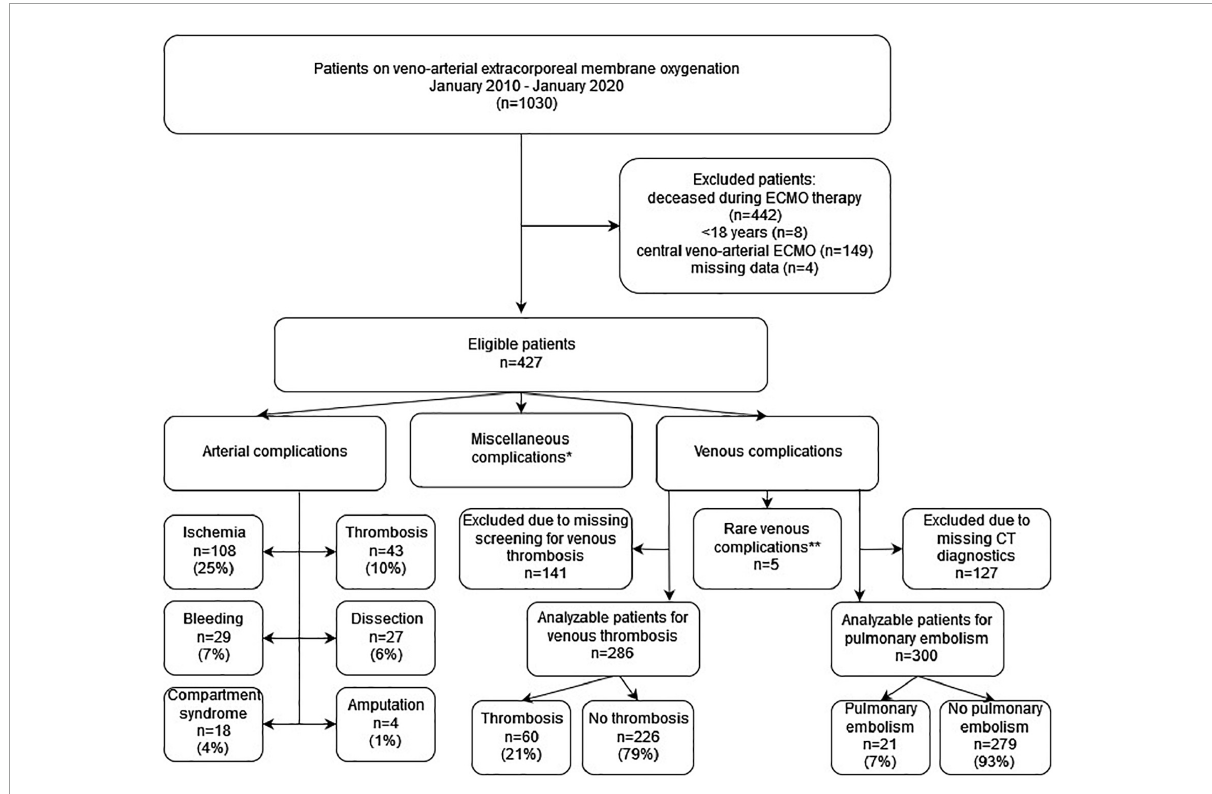
FIGURE1 Flowchart of the observational study evaluating arterial and venous complications in survivors of venoarterial extracorporeal membrane oxygenation of the extracorporeal life support registry at Regensburg; ECMO, extracorporeal membrane oxygenation; CT, computer tomography; *miscellaneous complications included initially failed puncture ( n = 24), bleeding ( n = 20), and arteriovenous fistula ( n = 1); **rare venous complications included bleeding ( n = 2), right atrial/ventricular wall perforation ( n = 2), and compartment syndrome of the leg with venous cannulation ( n =